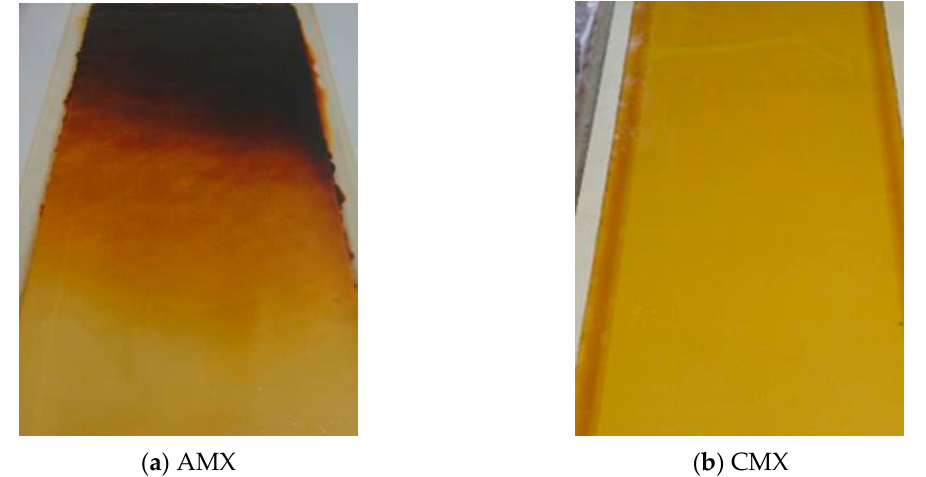
Figure 1. Neosepta ® AMX and CMX returned from the electrodialysis (ED) desalination plant of leachate for 8 years with appropriate cleaning-in-place (CIP) treatments; ( a ) AMX; ( b ) CMX.